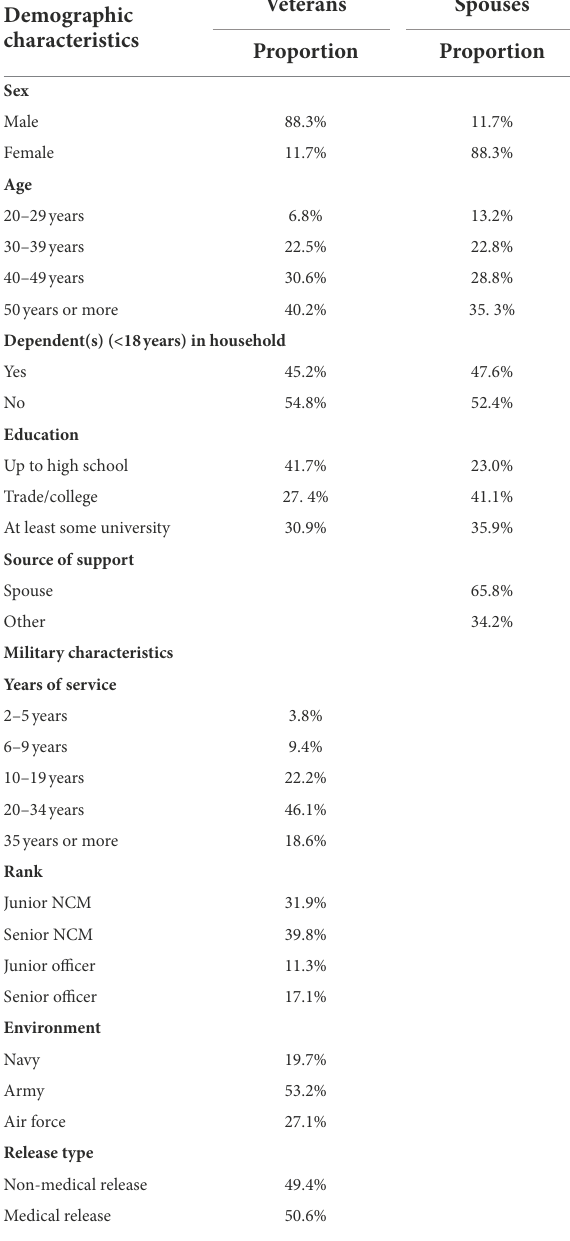
TABLE 1 Socio-demographic characteristics of Veterans and spouses ( N = 595). Demographic